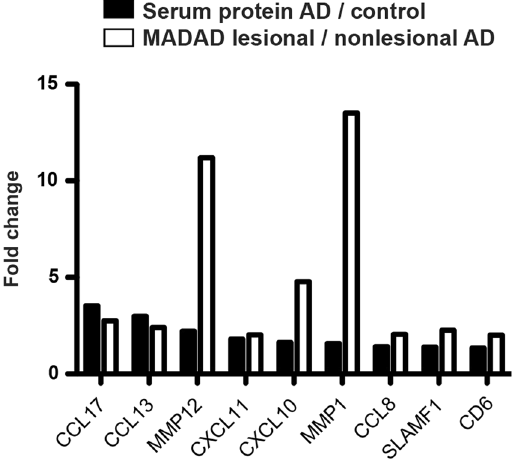
Figure 3. Blood-skin comparisons. Fold change comparisons of AD serum protein levels (AD vs. healthy controls) and skin MADAD transcriptome levels (lesional vs. non-lesional